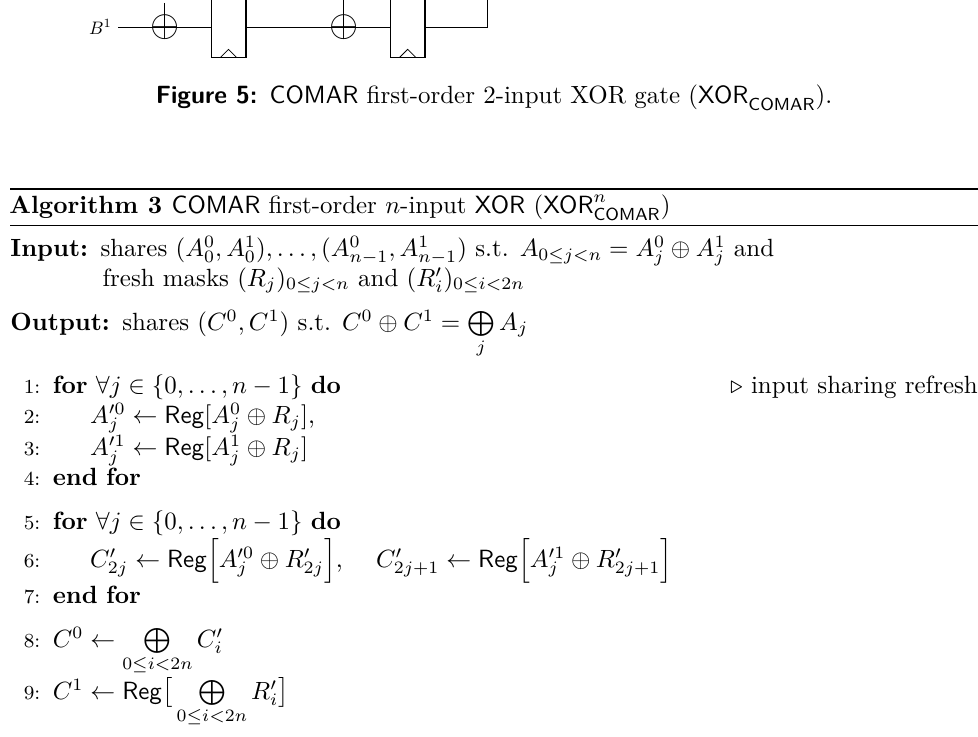
Figure 5: COMAR first-order 2-input XOR gate ( XOR